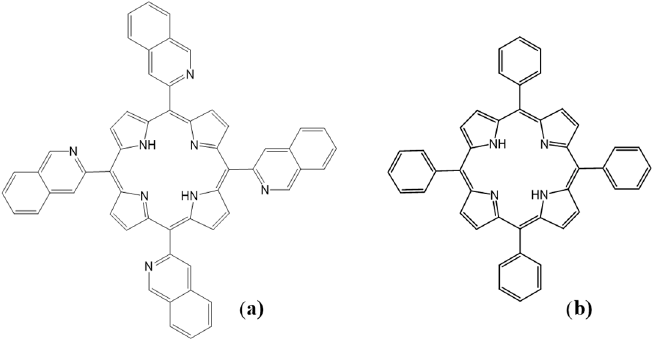
Figure 1. Structural representation of ( a ) 2-TQP and ( b ) TPP.